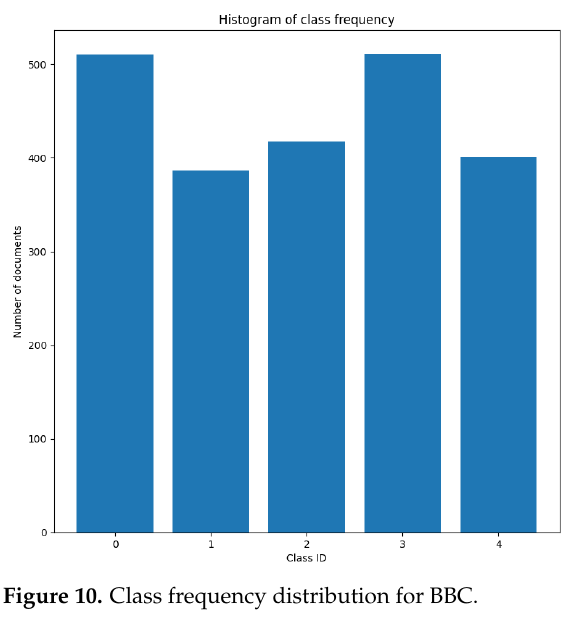
Figure 10. Class frequency distribution for BBC.